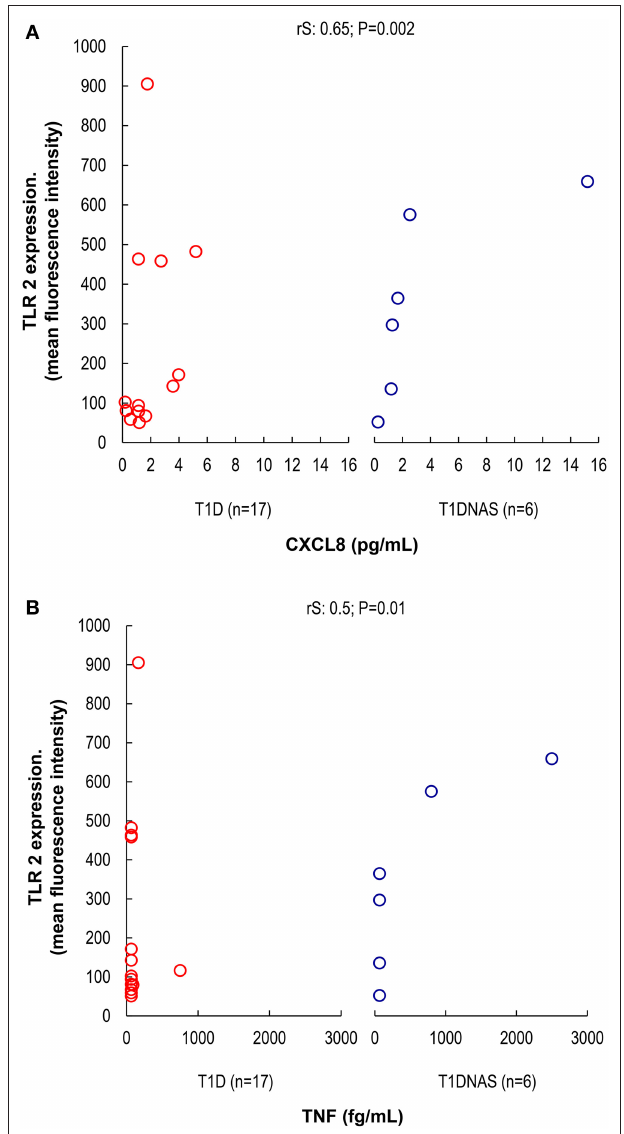
FIGURE 4 | (A) Correlation between TLR2 expression and serum concentration of CXCL8 (pg/mL) in monocytes by mean fluorescence intensity (MFI) in patients with type 1 diabetes (T1D) ( N = 17) and their non-affected siblings (T1DNAS) ( N = 6) rS: 0.65; P = 0.002. (B) Correlation between TLR2 expression and serum concentration of TNF- α (fg/mL) in monocytes by mean fluorescence intensity (MFI) in patients with type 1 diabetes (T1D) ( N = 17) and their non-affected siblings (T1DNAS) ( N = 6) rS: 0.5; P = 0.01.